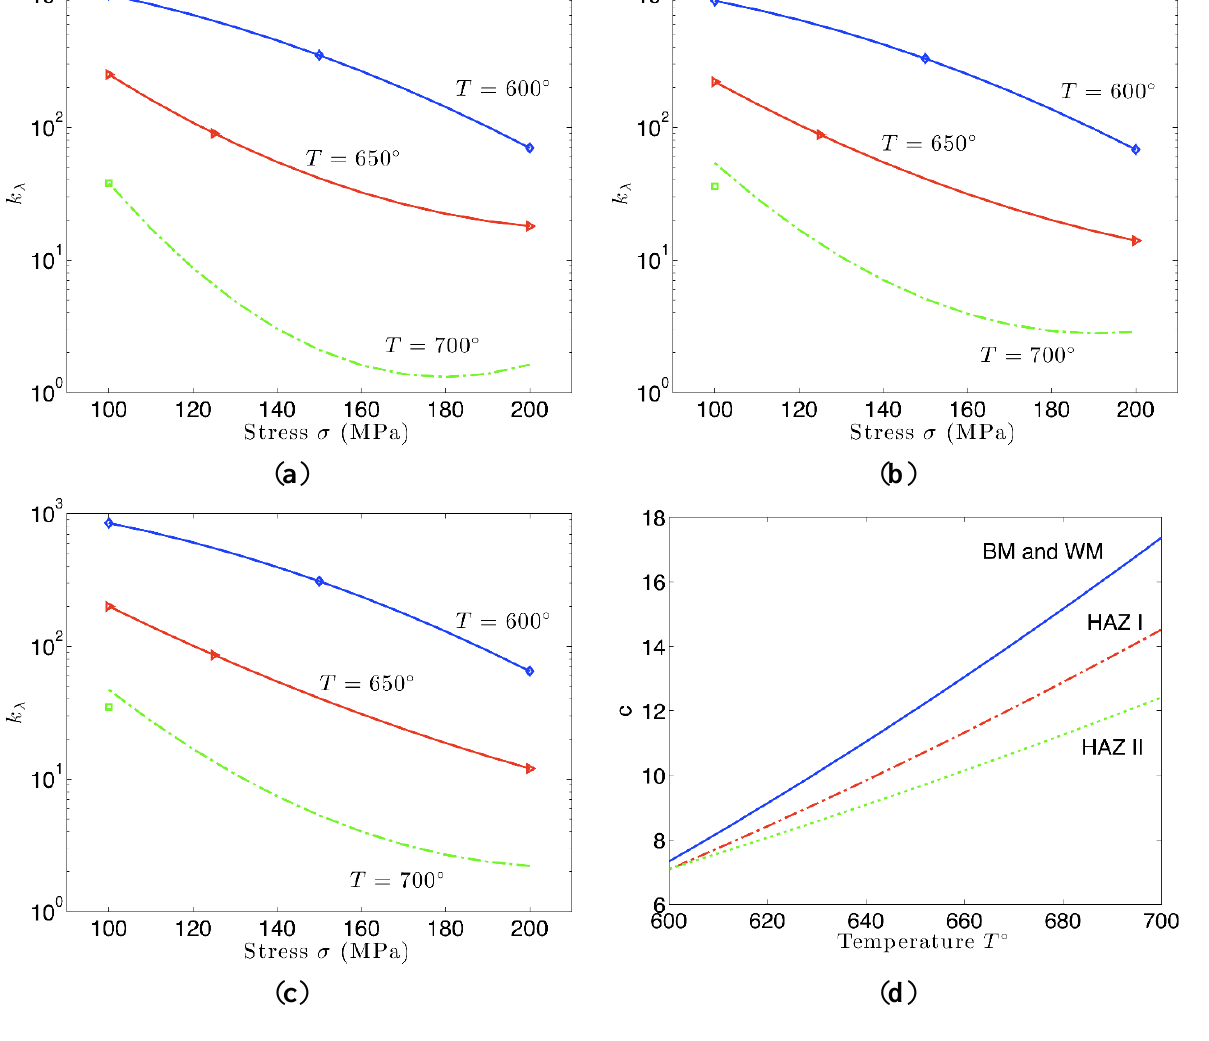
Figure 5. Logarithmic plot of k λ as a function of stress for T = 600 °C, 650 °C and 700 °C for ( a ) BM and WM, ( b ) HAZ I and ( c ) and HAZ II. ( d ) Quadratic curve-fitting of coefficient c . Solid curves represent fitted lines, while dash-dotted curve is the extrapolation for temperature T = 700